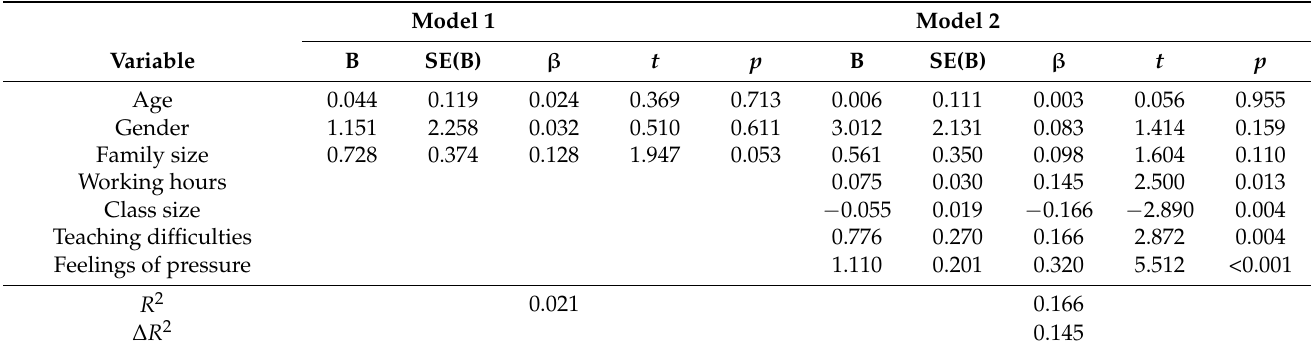
Table 4. Hierarchical regression analysis for variables predicting teacher